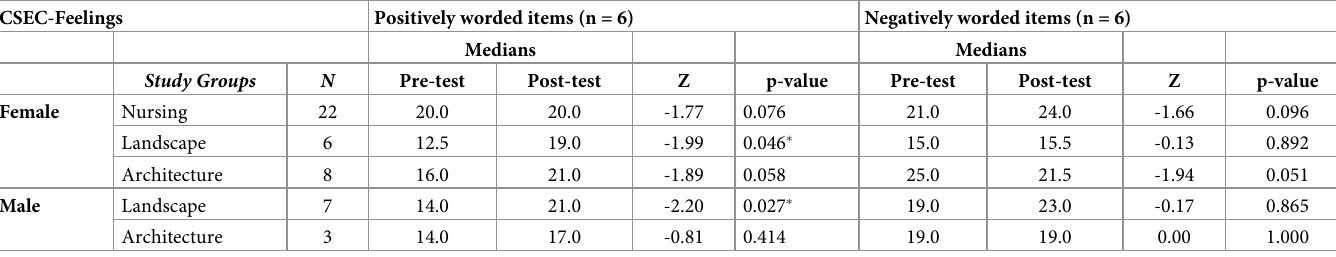
Table 2. Pre and Post- test CSEC-Feelings comparison in each study group by gender.